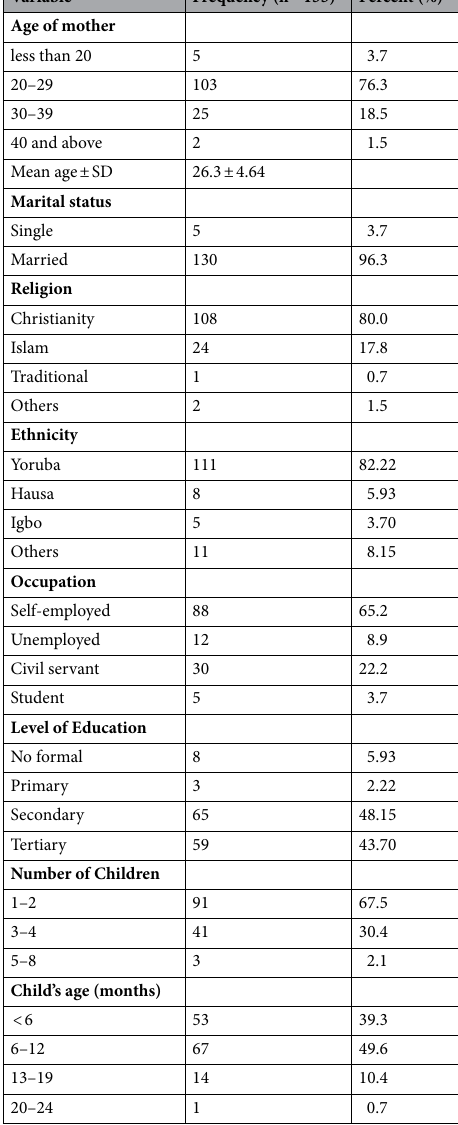
Table 1. Socio-demographic characteristics of respondents.